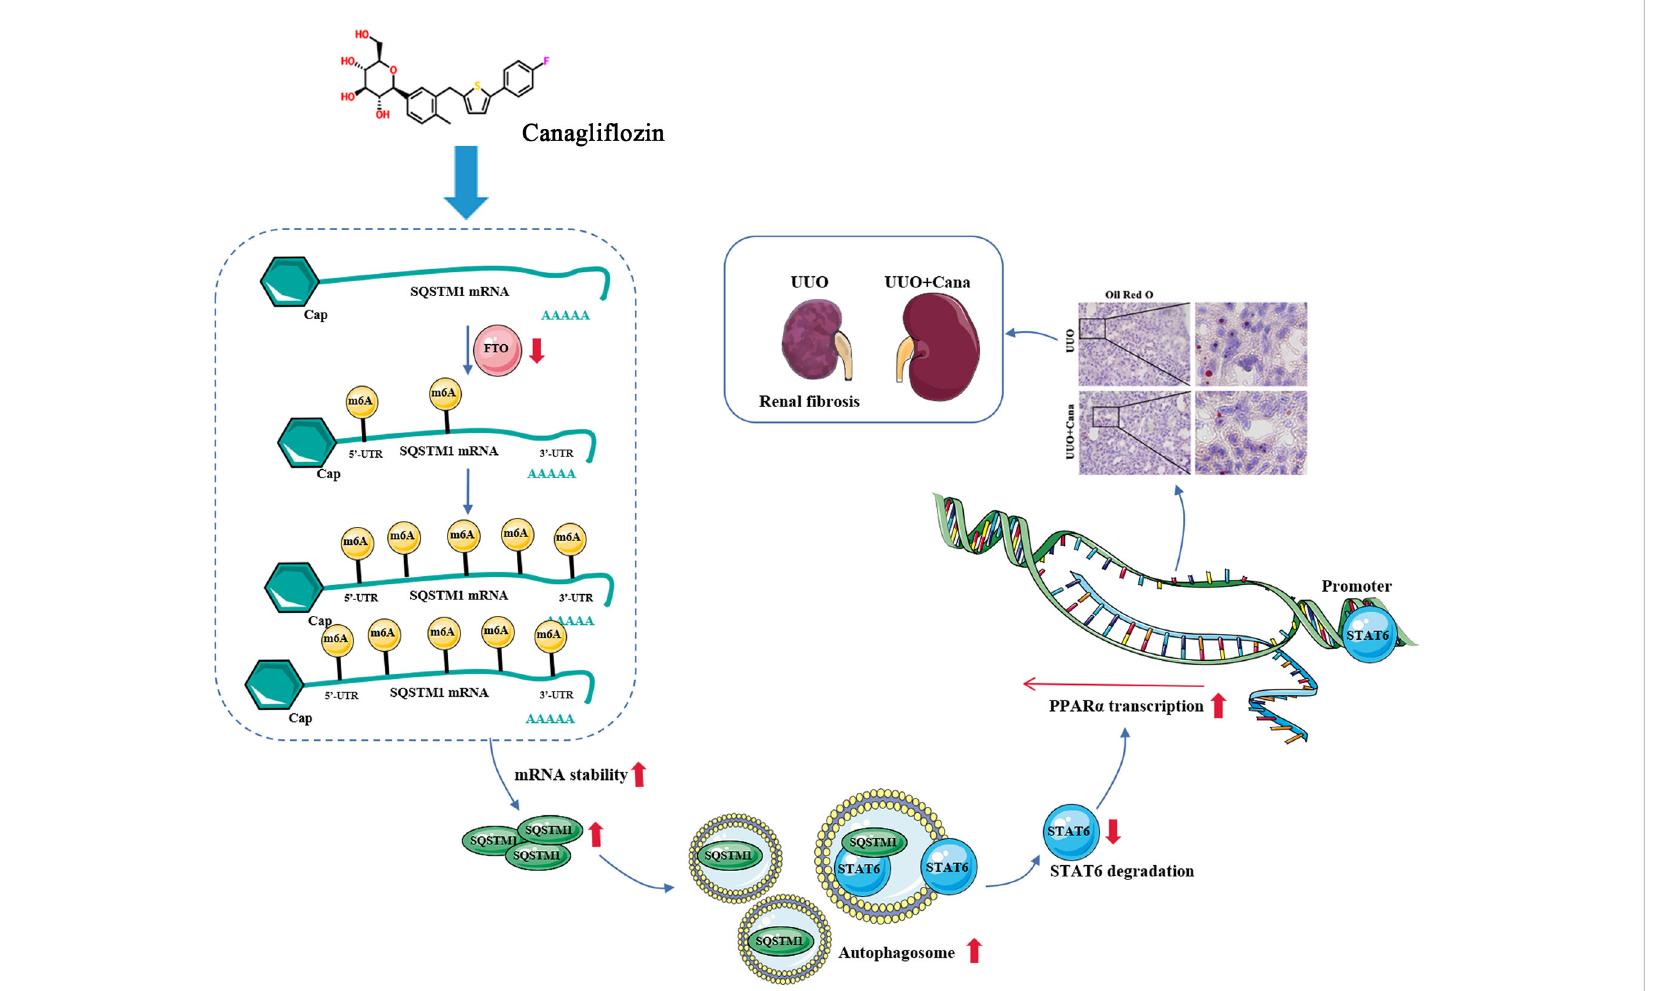
FIGURE 8 Proposed model for the therapeutic action of Cana against renal fi brosis. Cana attenuates renal tubular cells ’ FAO disorder and renal fi brosis by SQSTM1/autophagy-mediated STAT6 degradation in an m6A-dependent